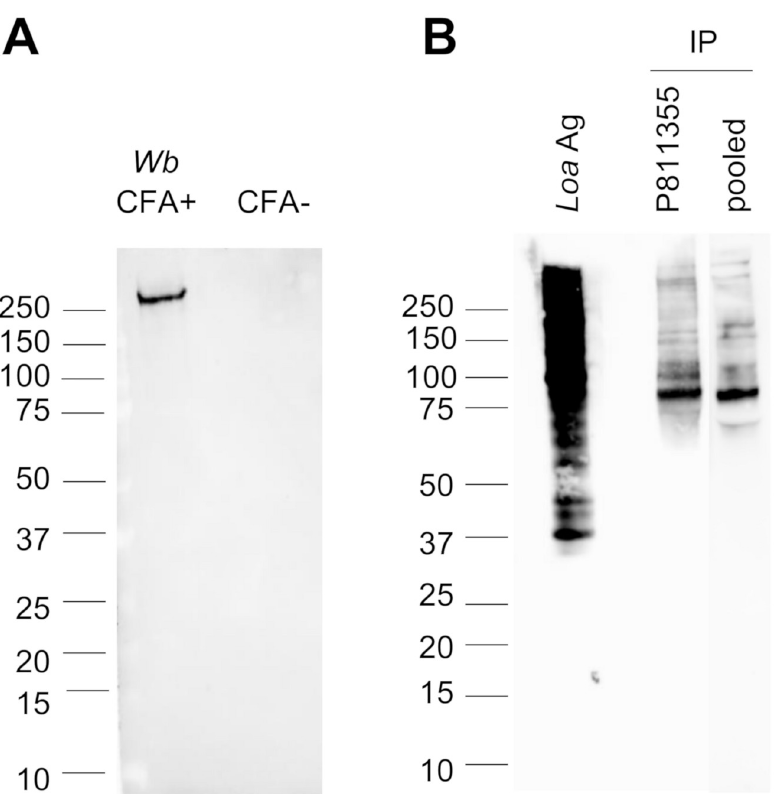
Fig 3. Loiasis sera positive by LF RDT contain multiple AD12 epitope-containing antigens. (A) AD12 western blot showing reactive bands in pooled sera from 13 individuals with W . bancrofti infection ( Wb CFA+) or 12 uninfected individuals (CFA-). (B) Antigens from sample P811355 (355), and pooled cross-reactive sera. Soluble L . loa antigen ( Loa Ag, 0.5 μ g) served as a positive control. Because the antigen level was much higher in sample P811355 than in the pooled sample, different chemiluminescent exposure times were used for the same blot (45 seconds for soluble L . loa antigen and P811355; 15 minutes for the pooled serum sample).